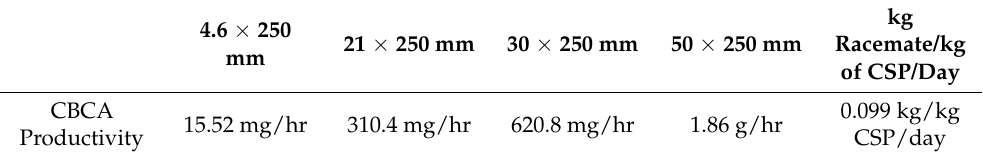
Table 8. Productivity of CBCA separation on various column